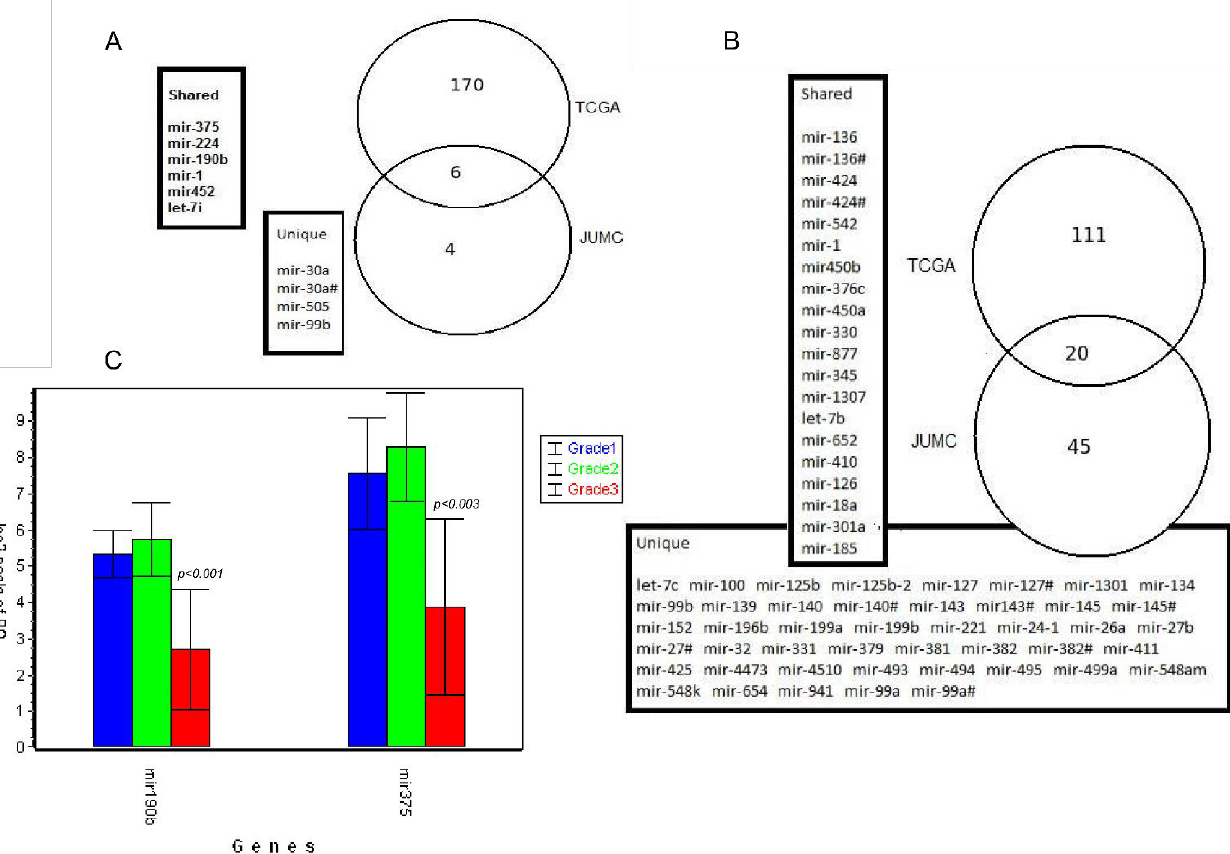
Figure 2. Overlapping miRNA genes between studied cohort (JUMC) and data collected by the Cancer Genome Atlas (TCGA) cohort. Venn diagrams shows the number of differentially expressed genes between G1 + G2 vs. G3 ( A ) and G1 vs. G2 + G3 ( B ). Unique and shared miRNA are listed in frames. ( C ) shows qPCR relative expression results of miR-190b and miR-375. JUMC, Jagiellonian University Medical College); studied cohort, TCGA; the Cancer Genome Atlas; blue bar, grade 1; green bar, grade 2; red bar, grade 3.